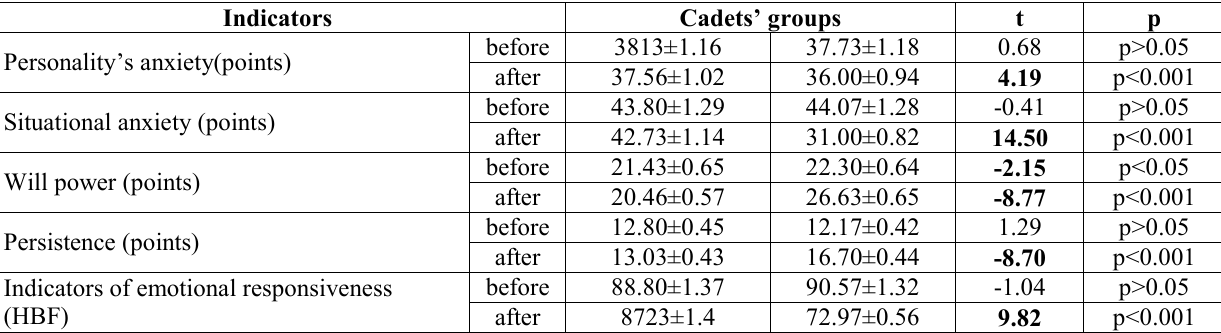
Indicators of mental abilities of control (n=30) and experimental groups’ cadets (n=30)before and after experiment, mX 